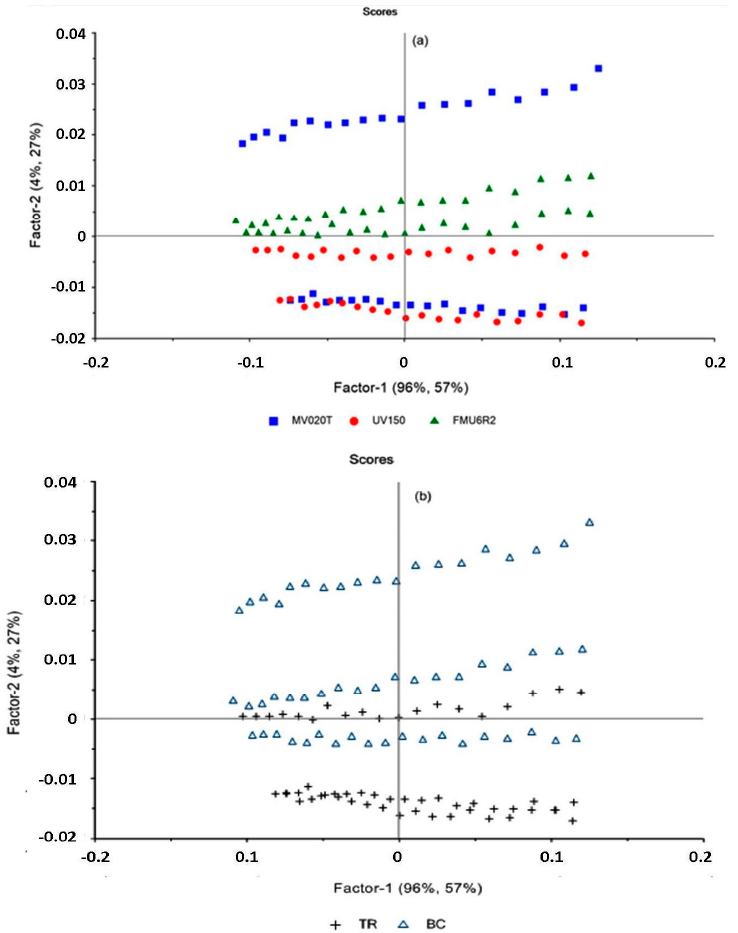
Figure 5. PLS Score plot for the two principal factors. ( a ) Measurements griped by membrane studied, and ( b ) measurements by type of processing.